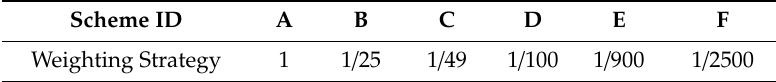
Table 4. The weight setting for GEO satellite observations.